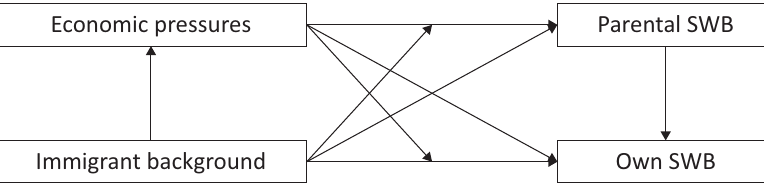
Figure 1. Hypothesized direct and indirect relationships between living in a family with an immigrant background and adolescents’ and young adults’ own subjective well-being (indicated as